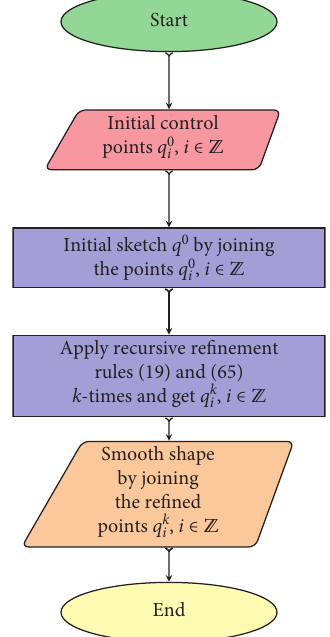
Figure 3: Flowchart to explain the geometric examples.